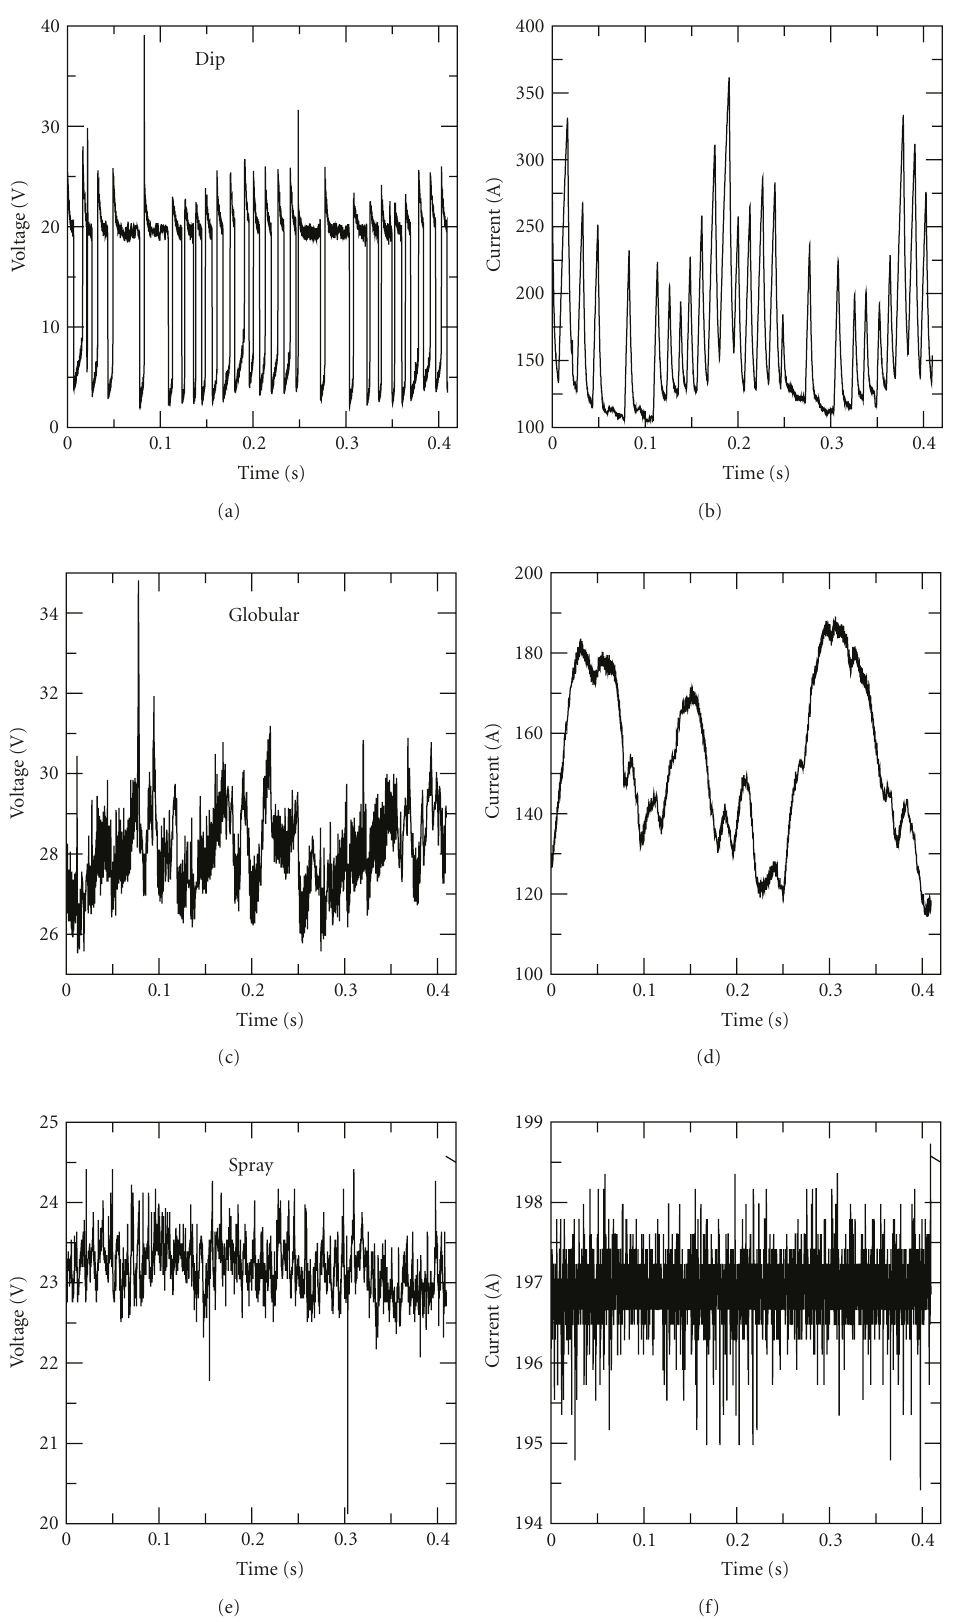
Figure 4: Examples of voltage (left) and current (right) time series obtained during the welding process under dip (top), globular (center), and spray (bottom) metal-transfer